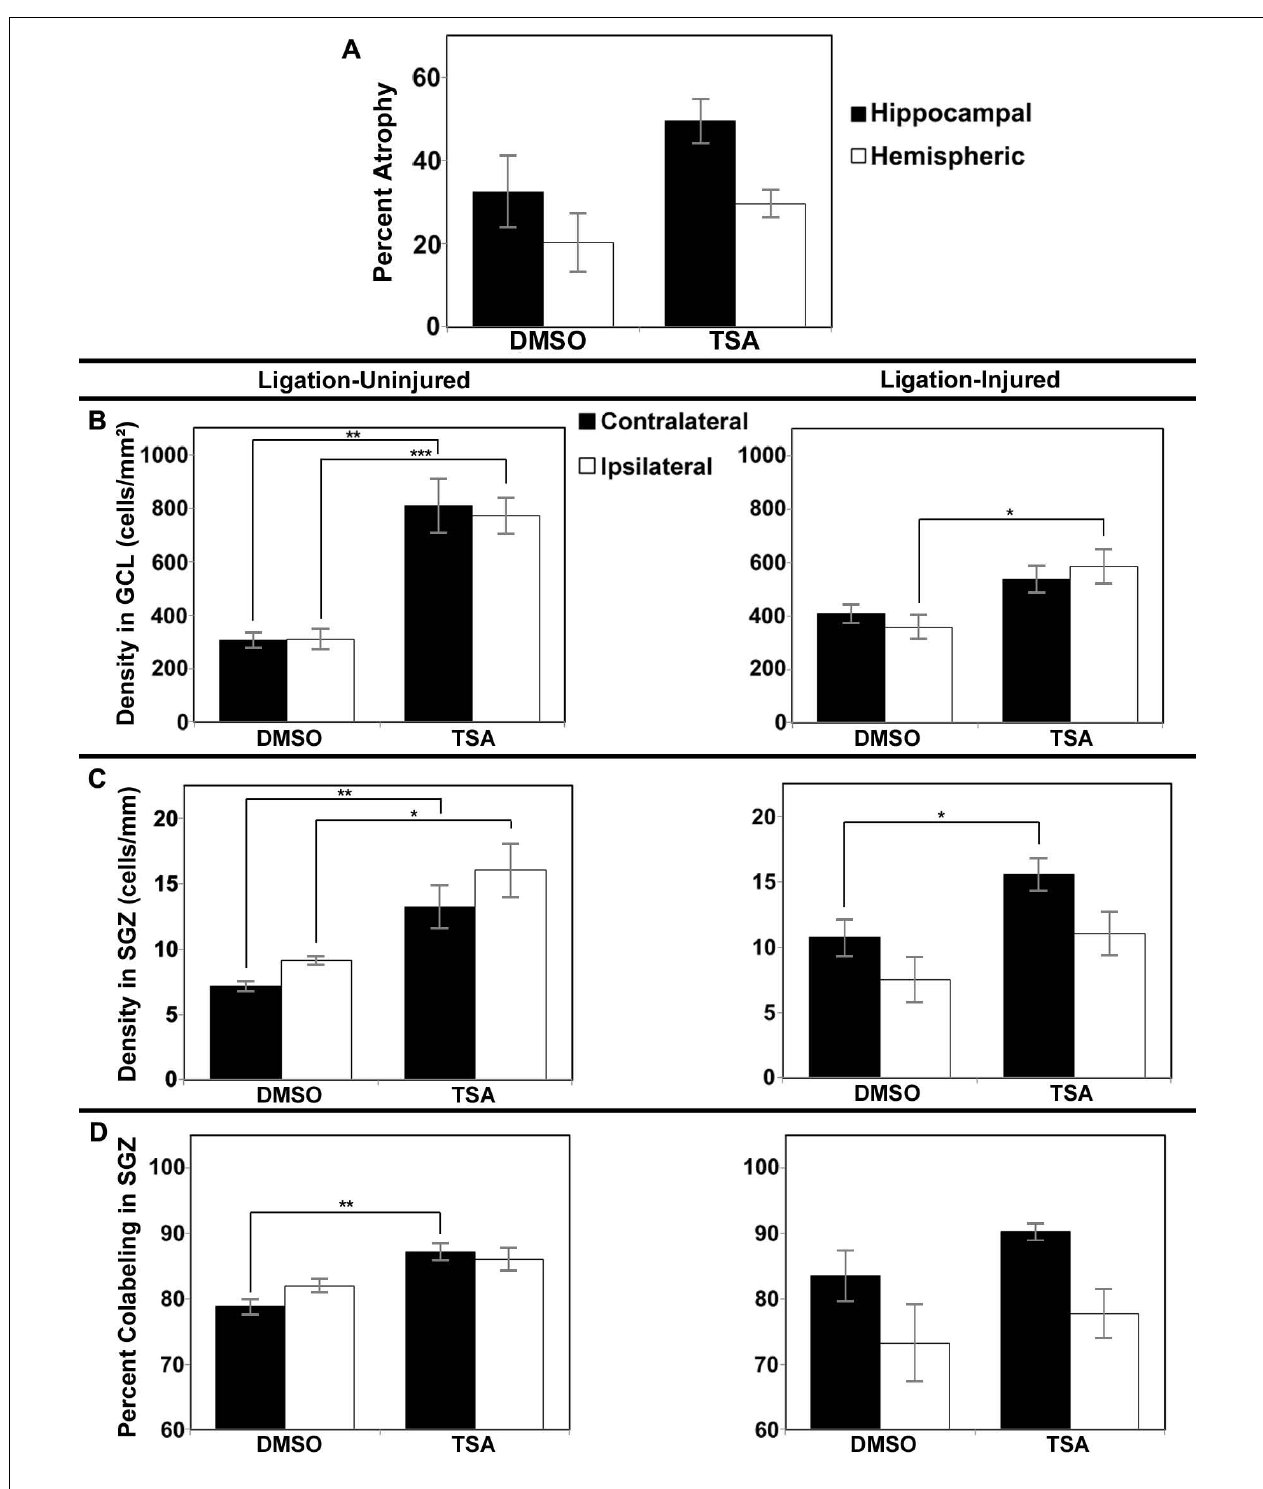
FIGURE 5 | Brain atrophy and dentate gyrus neurogenesis afterTSA treatment in Protocol 2. (A) Severity of infarct injury following P12 ligations quantified at P42 (14 days following cessation of treatment withTSA or DMSO-vehicle at P28) in ligation-injured mice. (B) Average densities of BrdU + /NeuN + within the granule cell layer (GCL) in both ligation-uninjured (left panel) and ligation-injured (right panel) mice treated withTSA or DMSO.